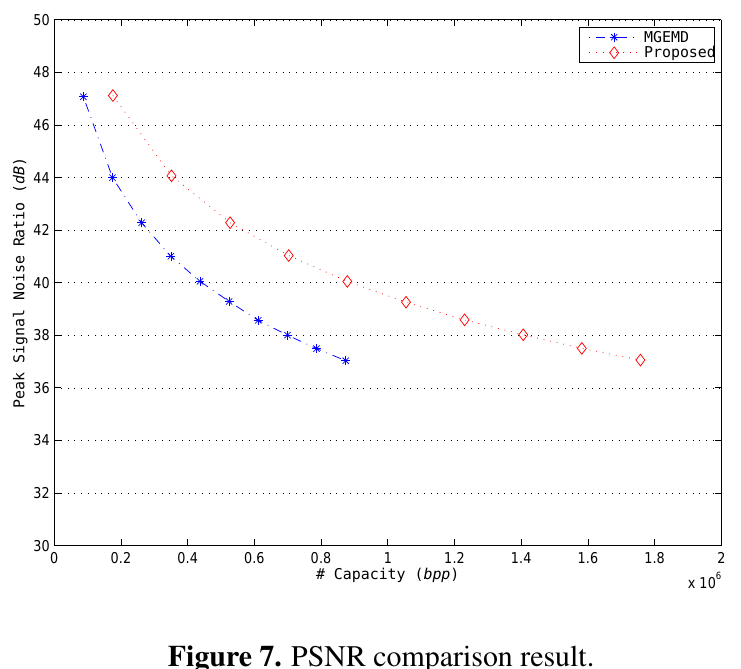
Figure 7. PSNR comparison